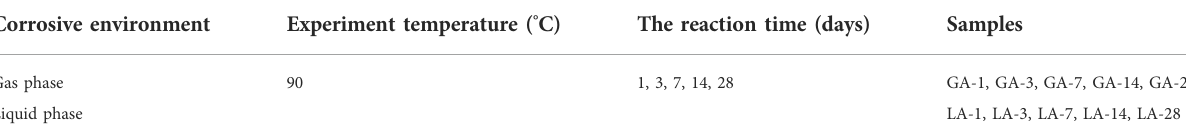
TABLE 1 Experimental conditions of the